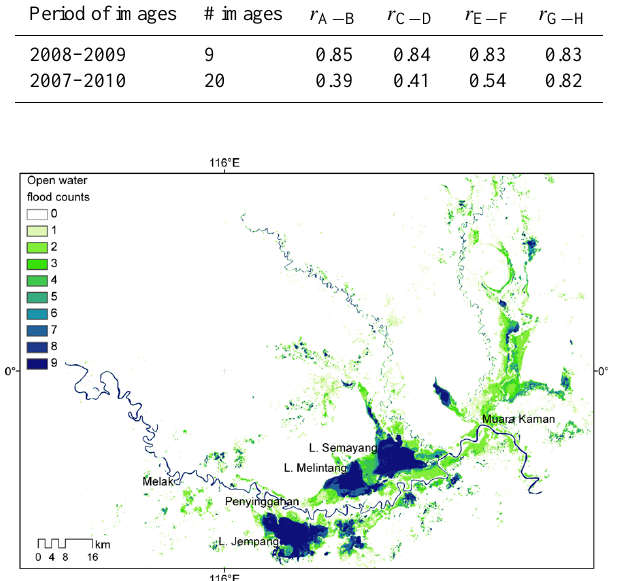
Fig. 9. Flood occurrence map of the middle Mahakam area obtained from the filtered (enhanced Lee) PALSAR images collected in 2008 and 2009.